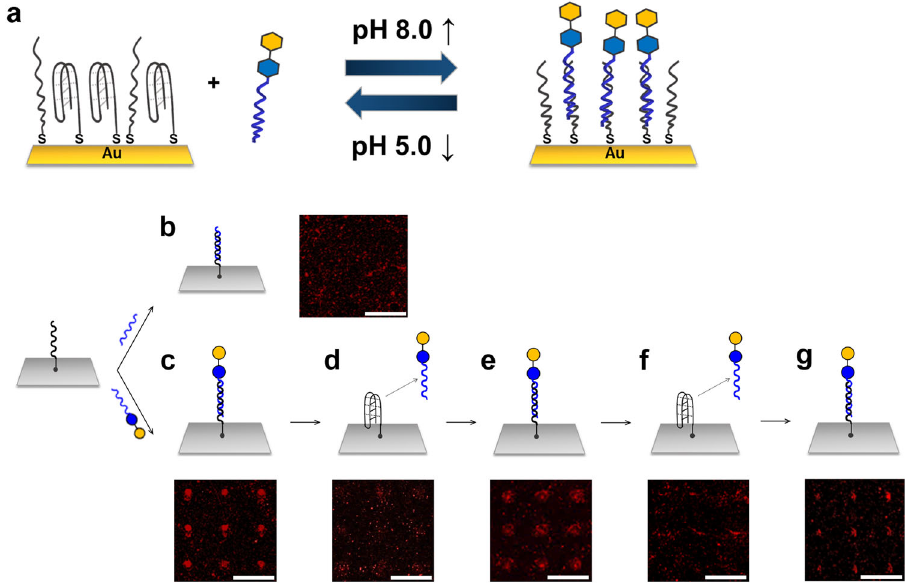
Fig. 1 Structure-switchable DNA-based glycan chip platform. a Schematic illustration of a structure-switchable DNA-based glycan chip platform using a pH- responsive i-motif DNA linker. b Schematic illustration and scanned raw image for hybridization of complementary single-stranded oligonucleotides with surface-immobilized i-motif DNAs under basic conditions (pH 9.0). c – g Schematic illustrations and scanned raw images for hybridization and denaturation of lactose-oligonucleotide conjugates by pH-responsive structural change in surface-immobilized i-motif DNAs. c The fi rst round hybridization of lactose- oligonucleotide conjugates with surface-immobilized i-motif DNAs under basic conditions (pH 9.0). d The fi rst round of denaturation of lactose-oligonucleotide conjugates from surface-immobilized i-motif DNAs under acidic conditions (pH 4.5). e The second round of hybridization of isolated lactose-oligonucleotide conjugates with surface-immobilized i-motif DNAs under basic conditions. f The second round of denaturation of lactose-oligonucleotide conjugates from surface-immobilized i-motif DNAs under acidic conditions. g The third round of hybridization of isolated lactose-oligonucleotide conjugates with surface- immobilized i-motif DNAs under basic conditions. The hybridized lactose-oligonucleotide conjugates were detected by using biotinylated RCA 120 lectin and Alexa Fluor ® 647-conjugated streptavidin. Scale bar is 800 μ m. Symbols: blue circle, Glc; yellow circle, Gal.